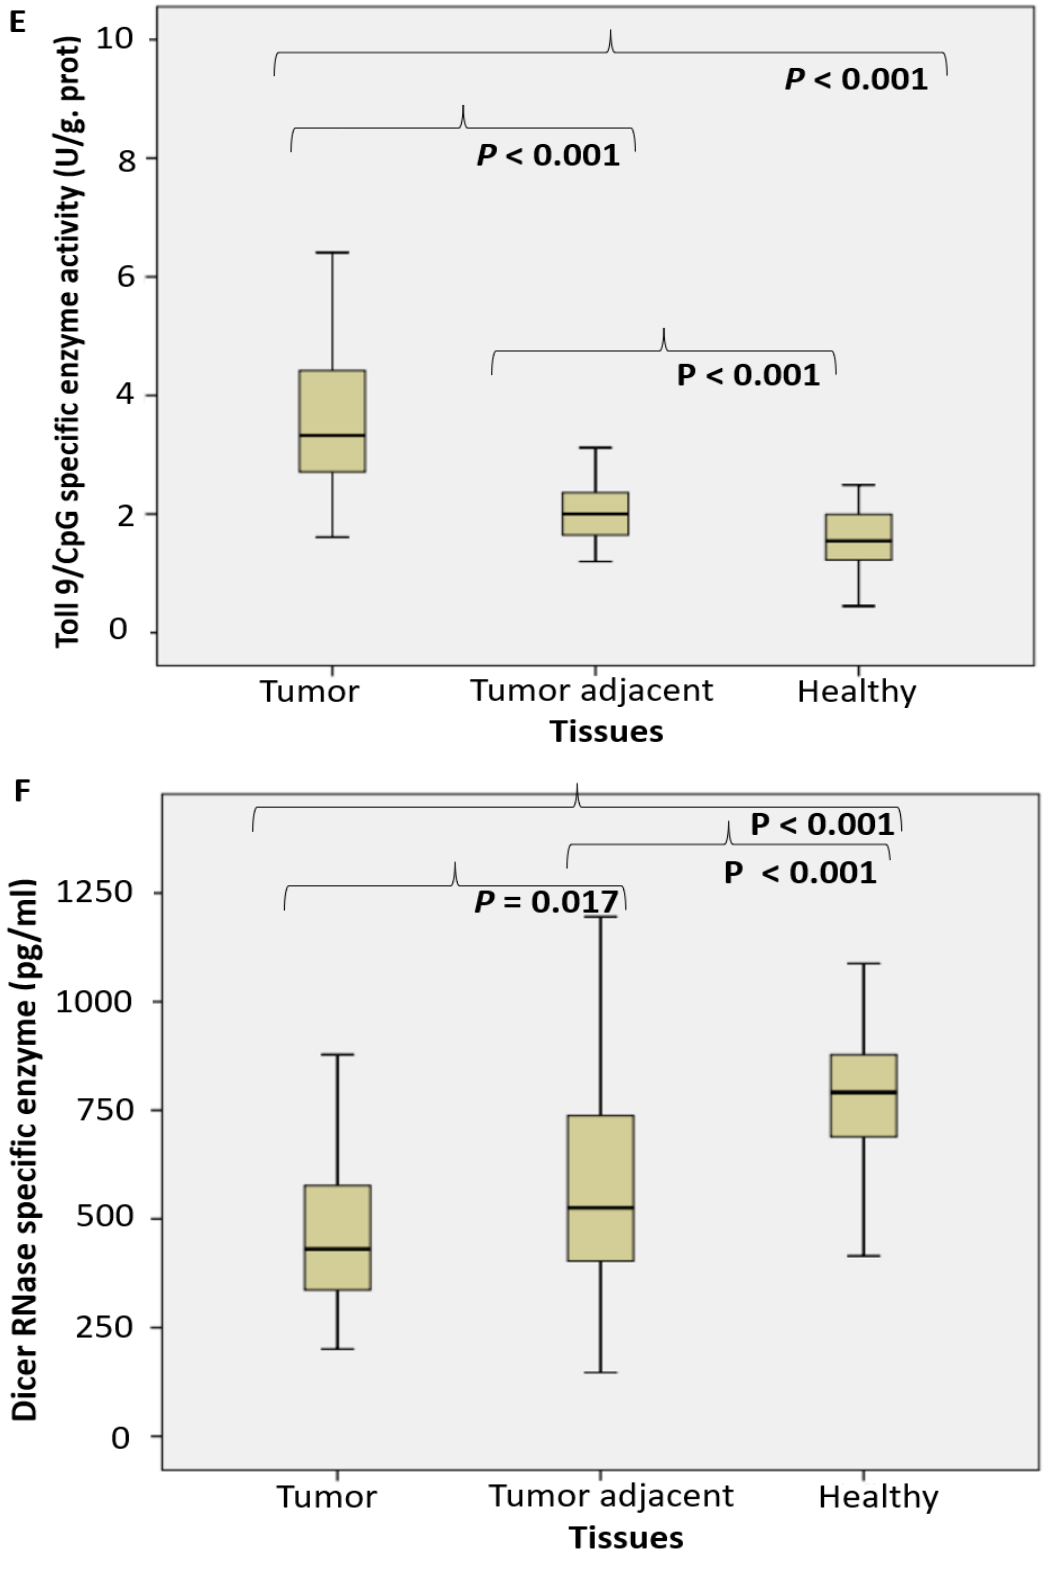
Figure 1. The endosomal acid nucleases activity toward the RNA, DNA, NA-sensing TLRs ligands and Dicer RNase expression profile in PC. (RNase T2 ( A ), Toll3 Poly IC ( B ), Toll 7/8 poly U ( C ), DNase II ( D ), Toll 9 CpG ( E ) specific enzyme activity (U/g prot) and Dicer RNase (pg/mL) ( F ) in prostate cancer, tumor adjacent and healthy tissue, accordingly).